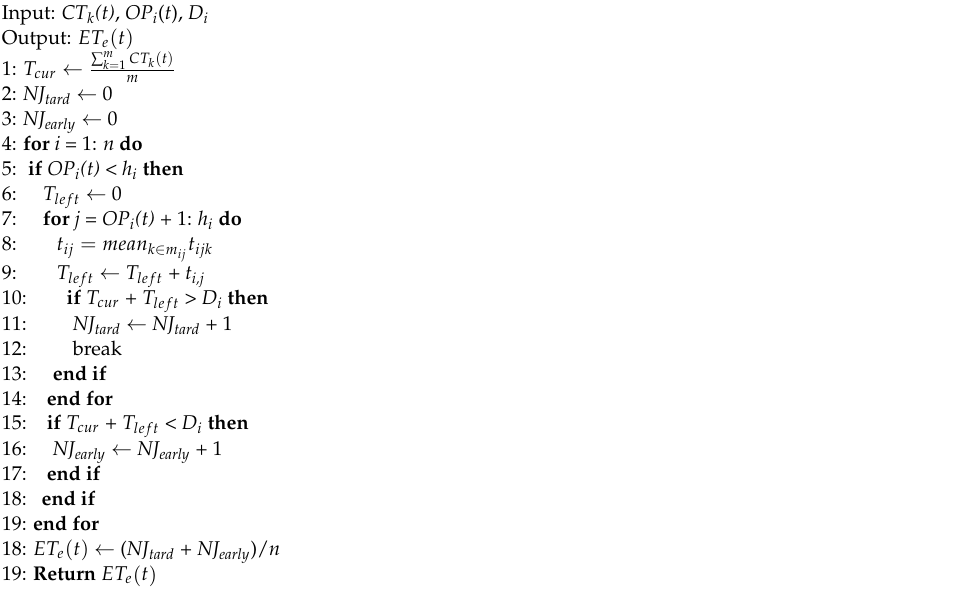
Algorithm 1 Procedure of calculating the estimated earliness and tardiness rate ET e ( t